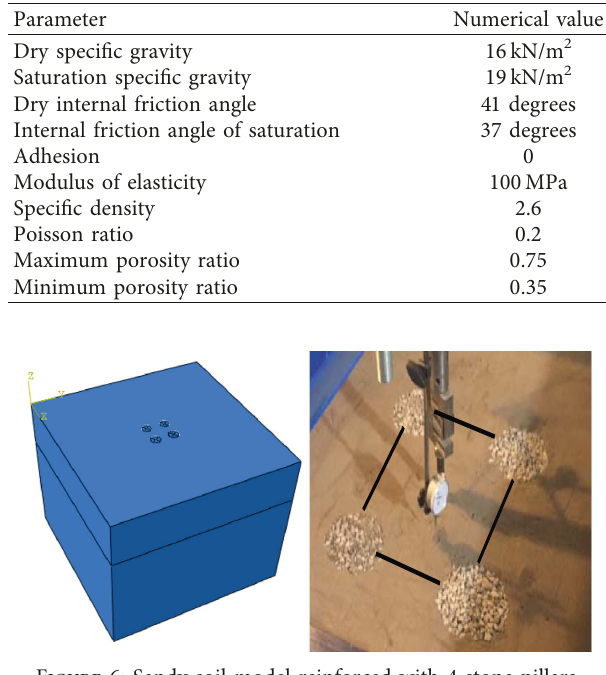
Table 4: Introducing the specifications of sand used to build stone columns.